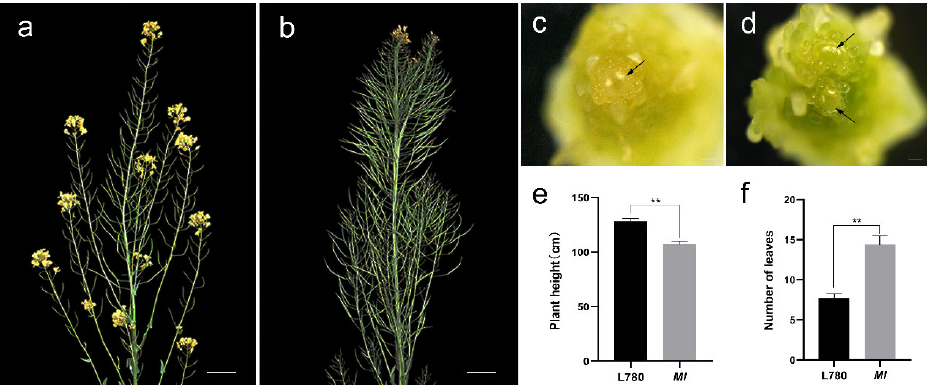
Figure 1. Multi inflorescence ‐ related traits and morphology of shoot apical meristems (SAMs) in MI . (a, b) Plant morphology of L780 ( a ) and MI ( b ); bar = 10 cm. Inflorescence meristems (IM) of L780 ( c ) and MI ( d ) in initial stage of IM differentiation. Black arrows indicate SAM; bar = 100 μ m. Comparison analysis of plant height ( e ) and leaf number ( f ) between wild type and MI . Error bars indicate SD ( ** p < 0.01; Student’s t test).